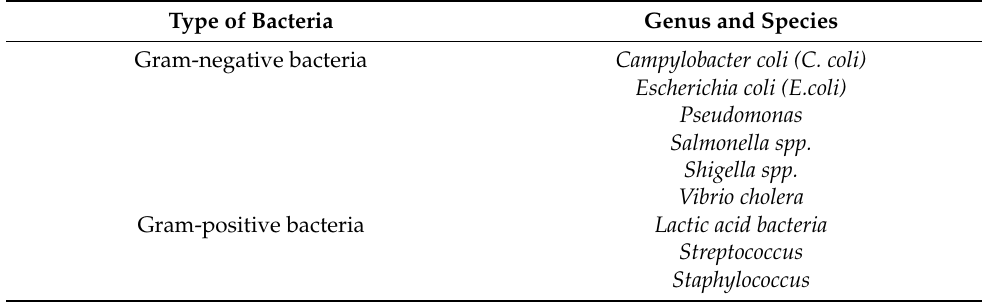
Table 1. Identified bacteria types in the industrial beverage wastewater